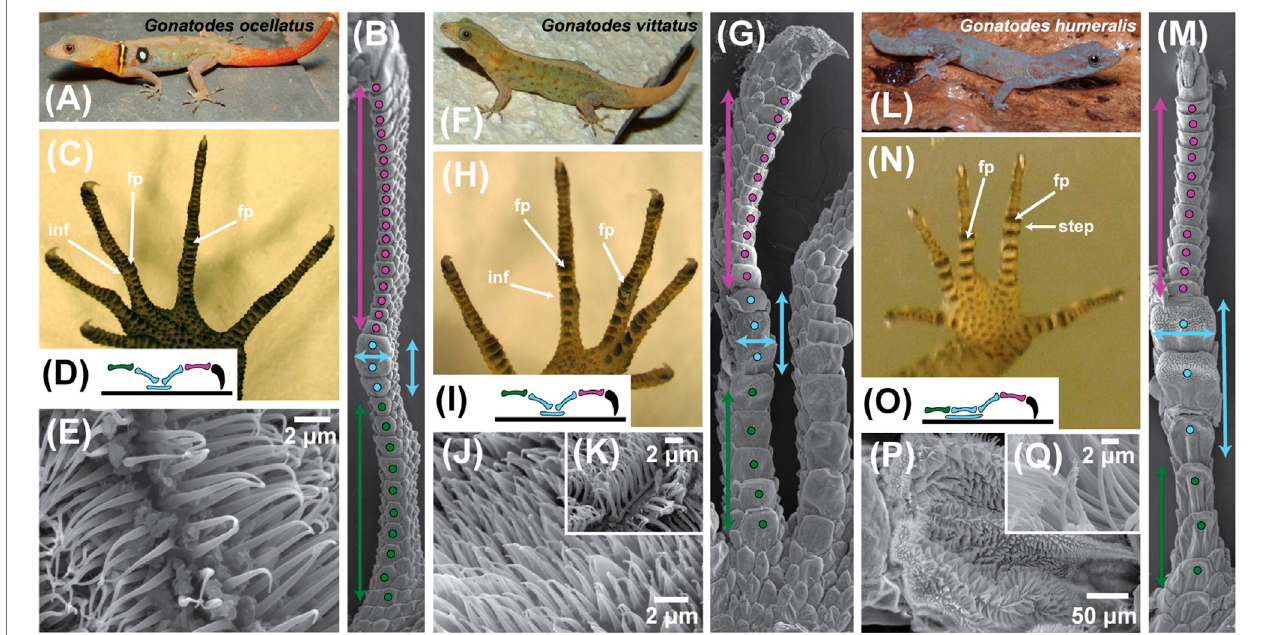
FIGURE 5 | Trends in digit form within the sphaerodactylid gekkotan genus Gonatodes . This genus is regarded as lacking subdigital toe pads but exhibits digital adhesive competence in one of its species. Shifts in form and proportion in association with the acquisition of whole animal adhesive competence are illustrated using three exemplar species (A) Gonatodes ocellatus , (F) G. vittatus and (L) G. humeralis . For each species a set of illustrations [panels (A) – (E) for G. ocellatus ; (G) – (K) for G. vittatus and (M) – (Q) for G. humeralis ) is used to illustrate the trends to whole animal adhesive competence in G. humeralis . Panels (B) , (G) and (M) depict scanning electron micrographs of the ventral aspect of digit IV of the left pes (hind foot) of the three species, with features of interest indicated by color-coded symbols. Panels (C),(H) and (N) representtheventralviewoftheleftpesofthethreespeciesandpanels (D) , (I) and (O) depictaschematicofthelateralviewoftheskeletonofdigit IV of the pes of each species, with the phalanges color coded to match the coding in panels (B) , (G) and (M) . Panels (E) , (J) and (K) , and (P) and (Q) are scanning electronmicrographsofthe fi lamentousoutgrowthsoftheepidermisbeneaththemid-digitin fl ectionpointofdigitIVofthepes.Codingconventionsareasfollows:purple dots – scalesbeneath thedistal region ofthe digit;purple double-headedvertical arrows – proximodistalextent ofthedistal regionofthedigit;purplephalanx – penultimate phalanx; blue dots – scales comprising the friction plate region of the digit; blue double-headed vertical arrows – length of the friction plate region; blue double-headed horizontal arrows – width of the friction plate region; blue phalanges – intermediate phalanges; blue ellipsoid – extent of the friction plate region below the intermediate phalanges; green dots – scales beneath the basal region of the digit; green double-headed vertical arrows – proximodistal extent of the basal region of the digit; green phalanx – basal phalanx; curved, black claw – ungual phalanx and claw. The blue and green dotted regions combined constitute the proximal region of the digit. Abbreviations: fp – friction plates; inf – digital in fl ection; step – step-like transition between the proximal and distal digital regions in G. humeralis